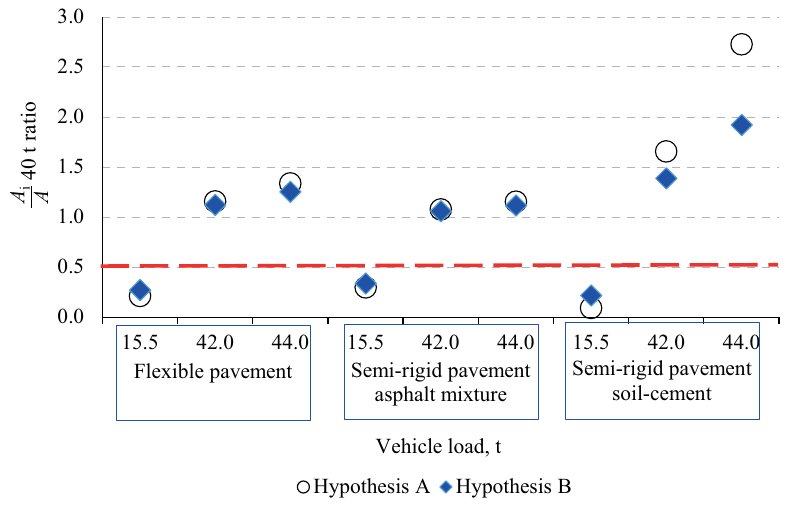
Figure 8. Mean values of the ratios between the coefficients of aggressiveness of each load and 40